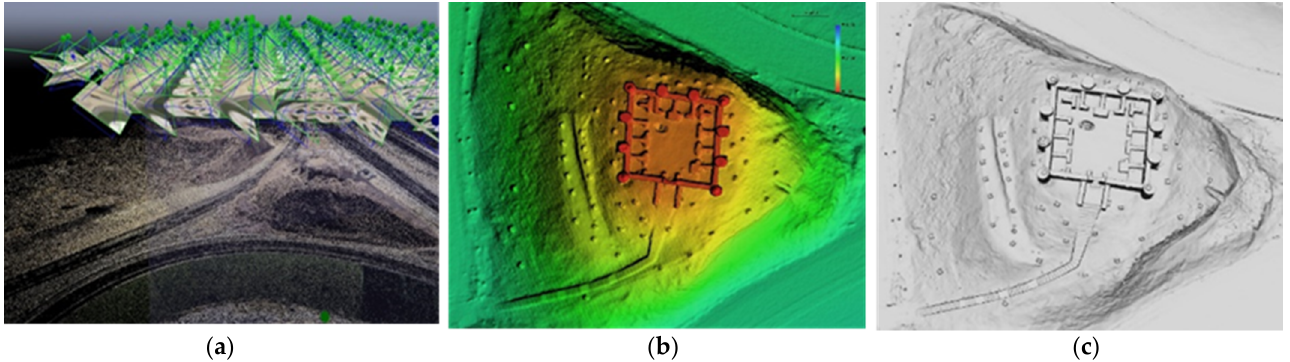
Figure 14. ( a ) Point cloud generation from UAV images. ( b ) UAV–SfM digital surface model. ( c ) UAV 3D model.